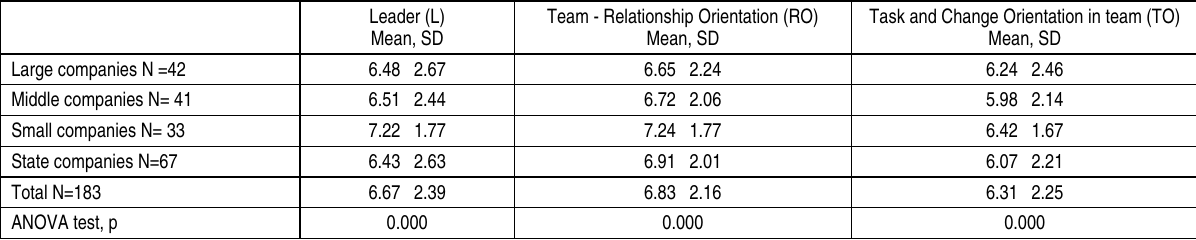
Table 6. The perception of elements of LIC (impact of leader trustworthiness and behavior, and relationship, task and change orientation) in different types of Estonian organzations in 2015 Leader (L) Mean, SD